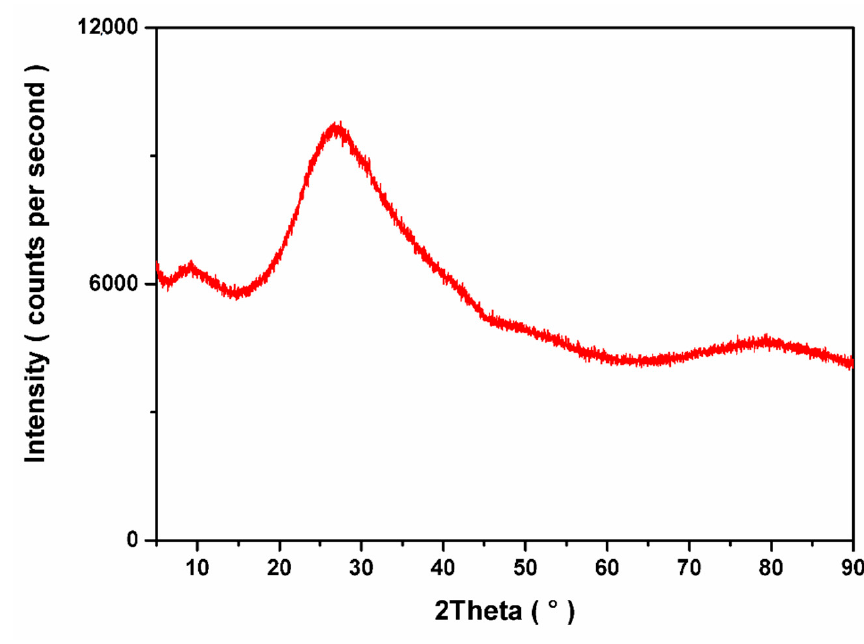
Figure 4. XRD patterns calcined at 800 °C—amorphous character.